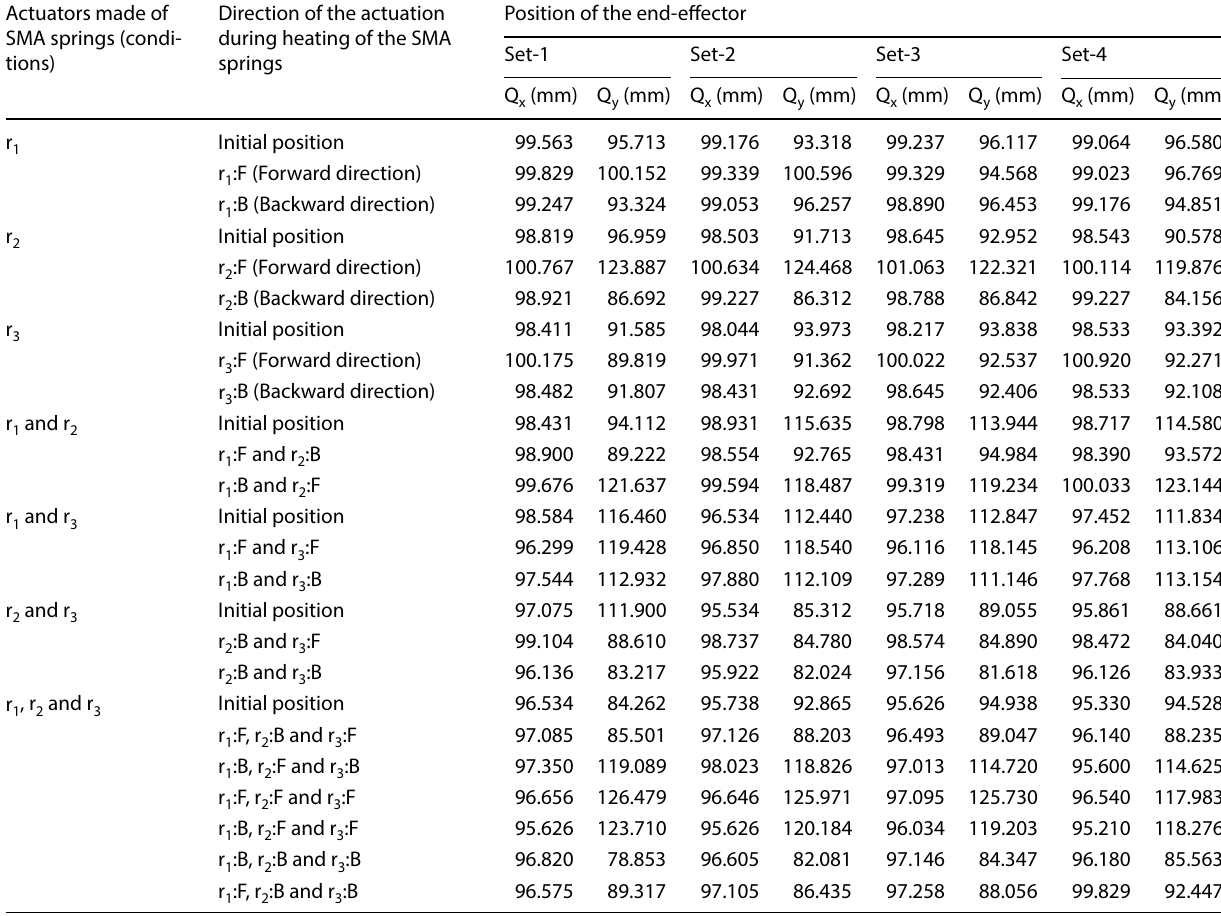
Direction of the actuation during heating of the SMA